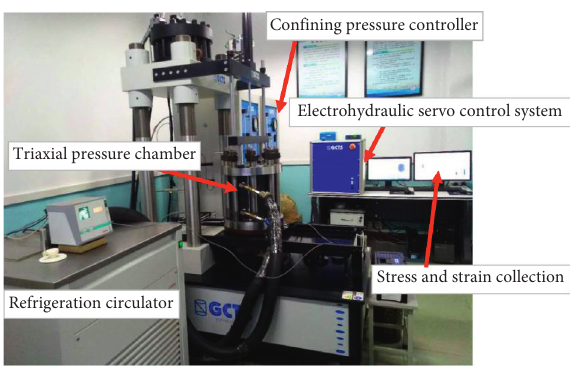
Figure 2: Electrohydraulic servo control low-temperature and high-pressure rock three-axis test system.